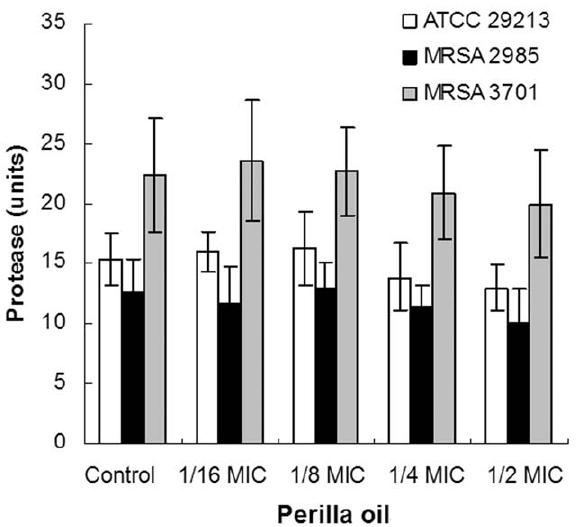
Figure 4. Protease units of S. aureus culture supernatants. Bacteria were cultured with increasing concentrations of perilla oil to reach an OD 600nm of 2.5. The culture supernatants were collected by centrifugation, and used for proteolytic activity assay. Values represent the mean 6 SD for three independent experiments.